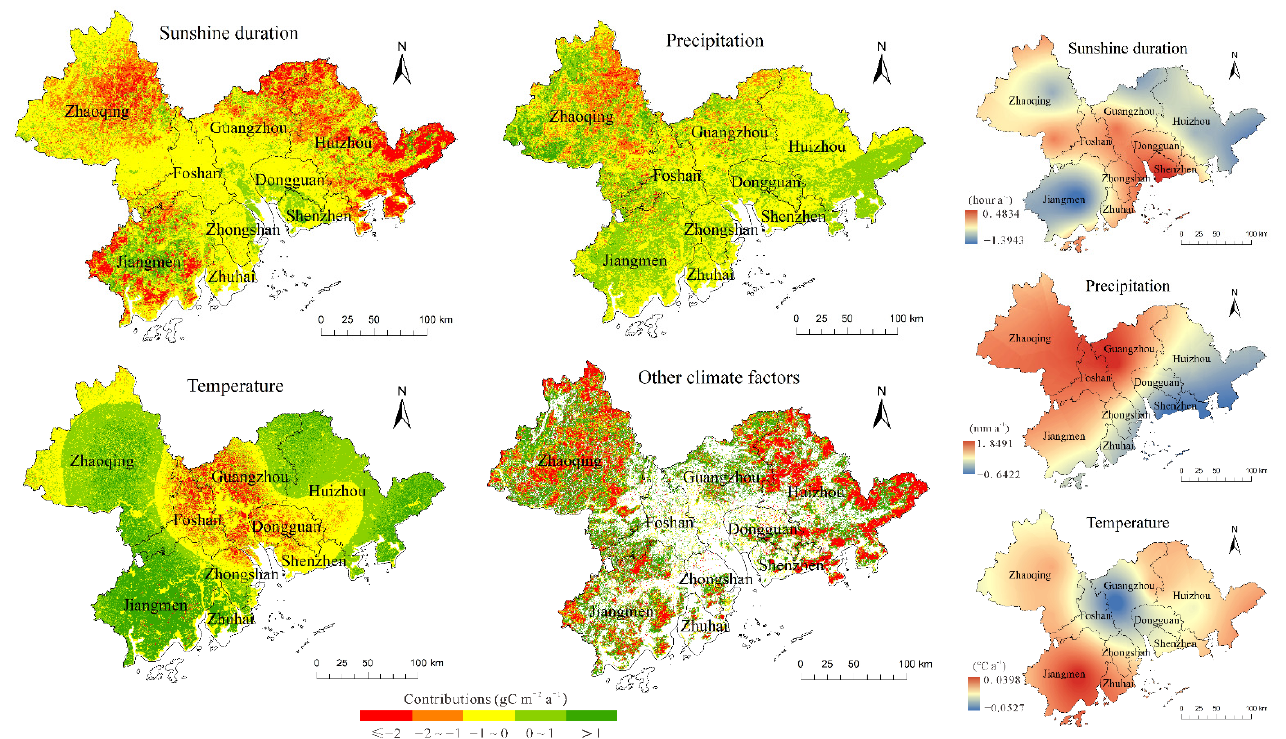
Figure A1. Contribution of meteorological factors to net primary productivity (NPP) and the changing trend of meteorological factors.